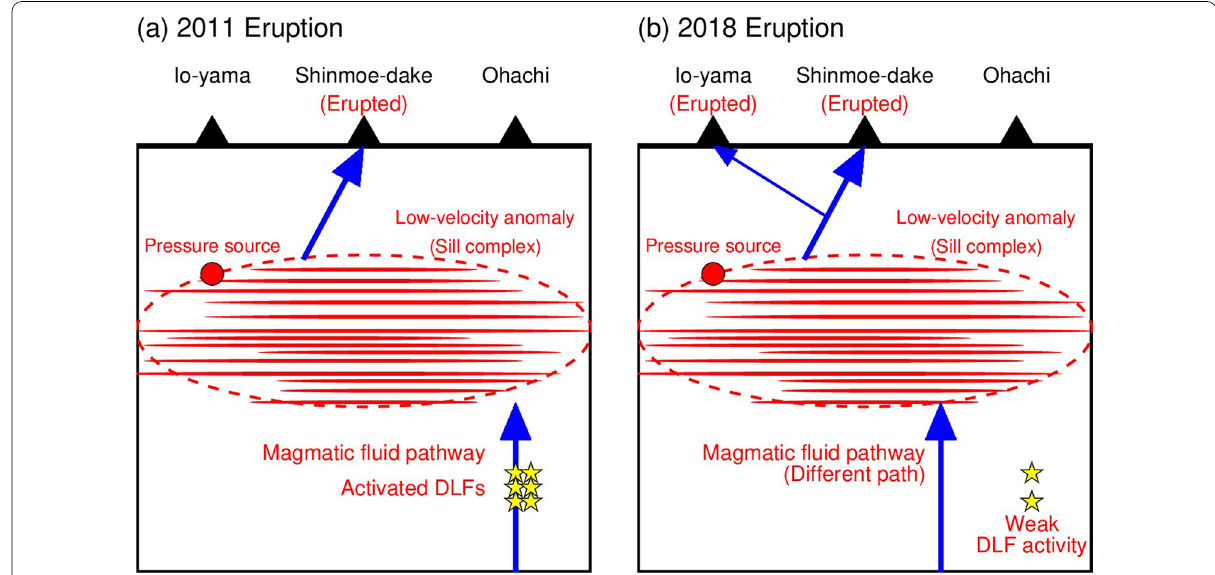
Fig. 5 Model of deep magma supply path and ascension of magmatic fluids during the a 2011 and b 2018 eruptions (referred as Nishida et al. (2020)). Yellow stars mark the DLF earthquake hypocenters. Blue arrows indicate the magmatic fluid pathways. The large red ellipse denotes the low-velocity anomaly, which has been interpreted to represent magmatic sills (Nagaoka 2020). The solid red circle marks the location of measured crustal deformation in 2011 (Nakao et al. 2013), and it may be similar to the eruption of 2018 (Geospatial Information Authority of Japan